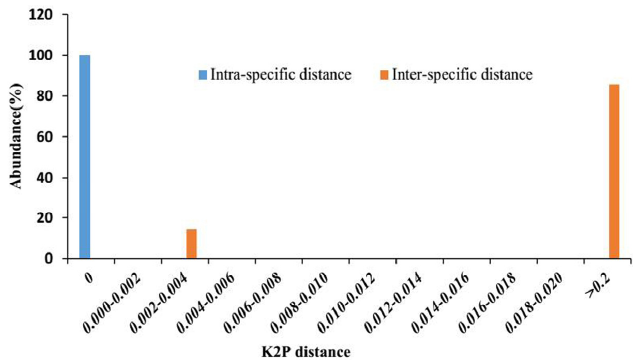
Figure 2. Relative distribution of interspecific divergence between congeneric species